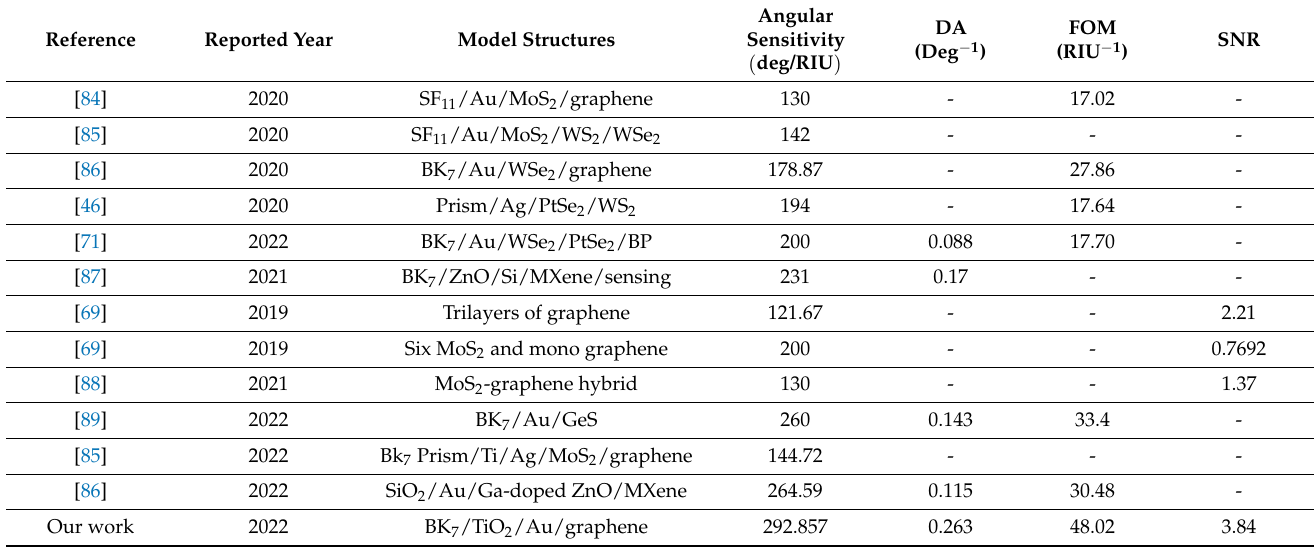
Table 7. Comparison of the proposed biosensor with some recently reported works.